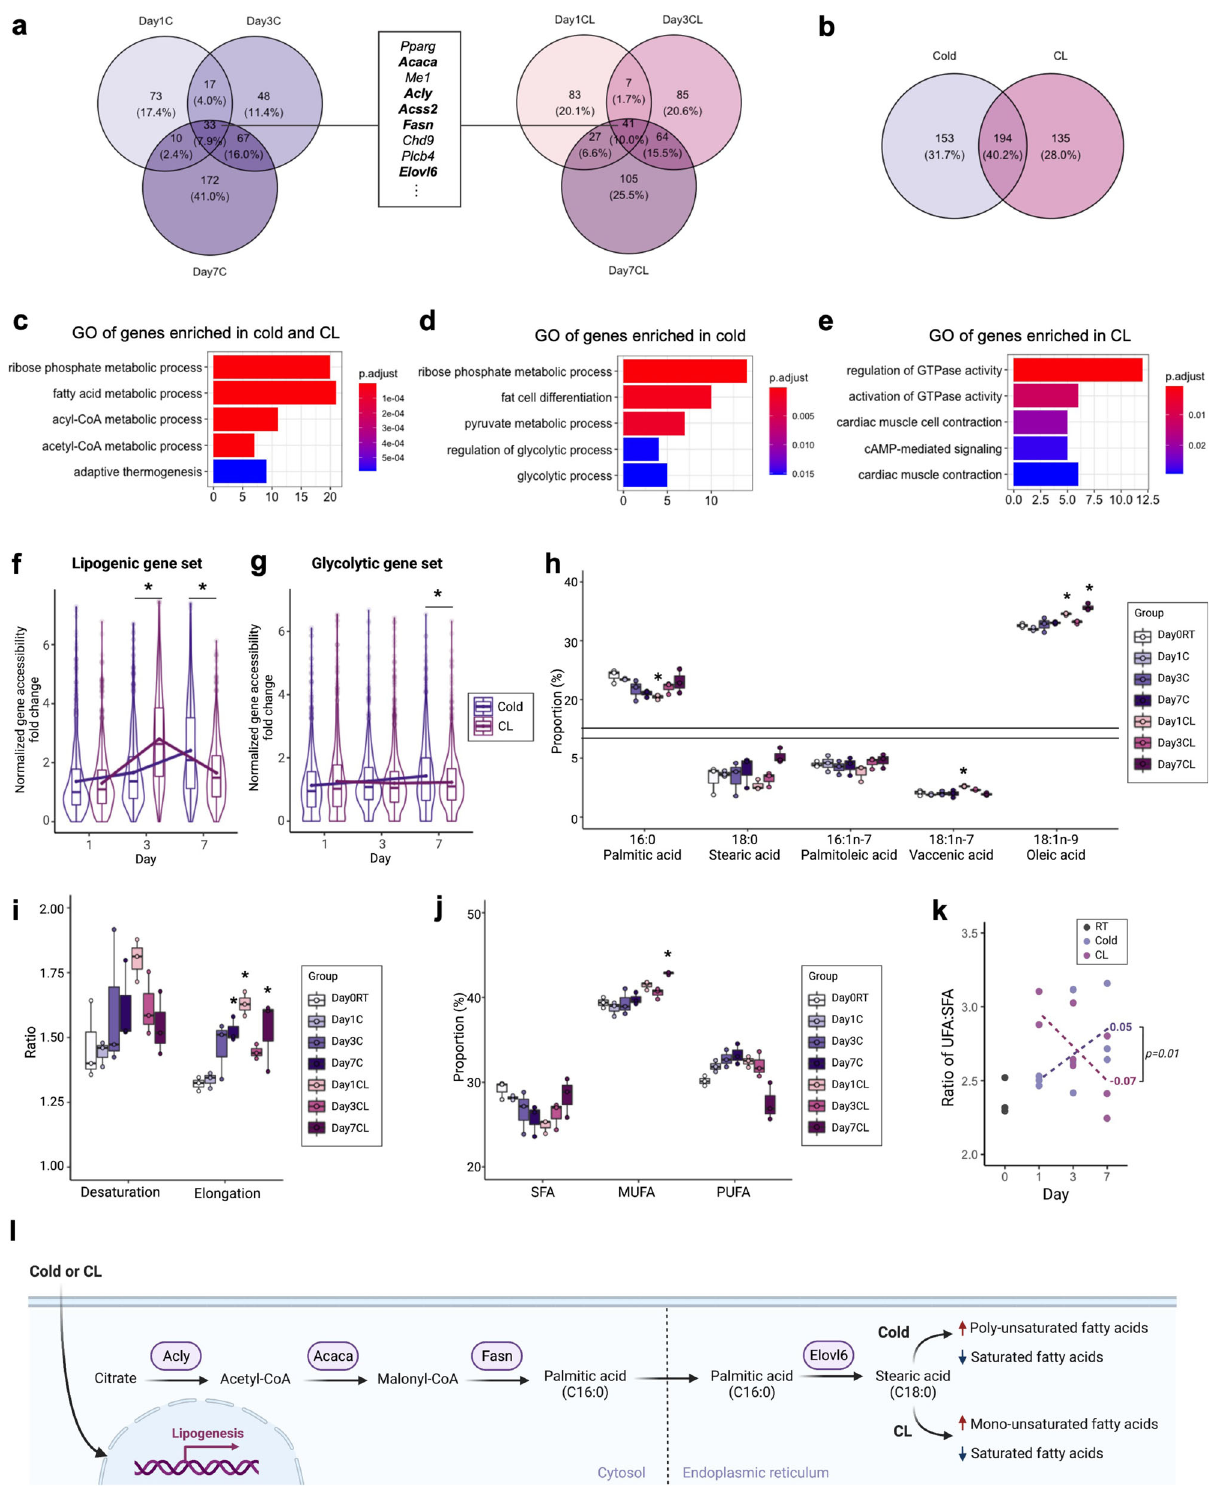
the same iWAT used for snATAC-seq by gas-chromatography mass spectrometry (GC-MS)-based lipid pro fi ling. The most abundant free FAs were oleic acid (18:1n-9), linoleic acid (18:2n- 6), and palmitic acid (16:0), making up around 82% of the FA content of the depot (Fig. 7h and Supplementary Fig. 8c). Palmi- toleic acid (16:1n-7), stearic acid (18:0), and vaccenic acid (18:1n- 7) were the next most abundant free FAs, which account for 10% (Fig. 7h and Supplementary Fig.